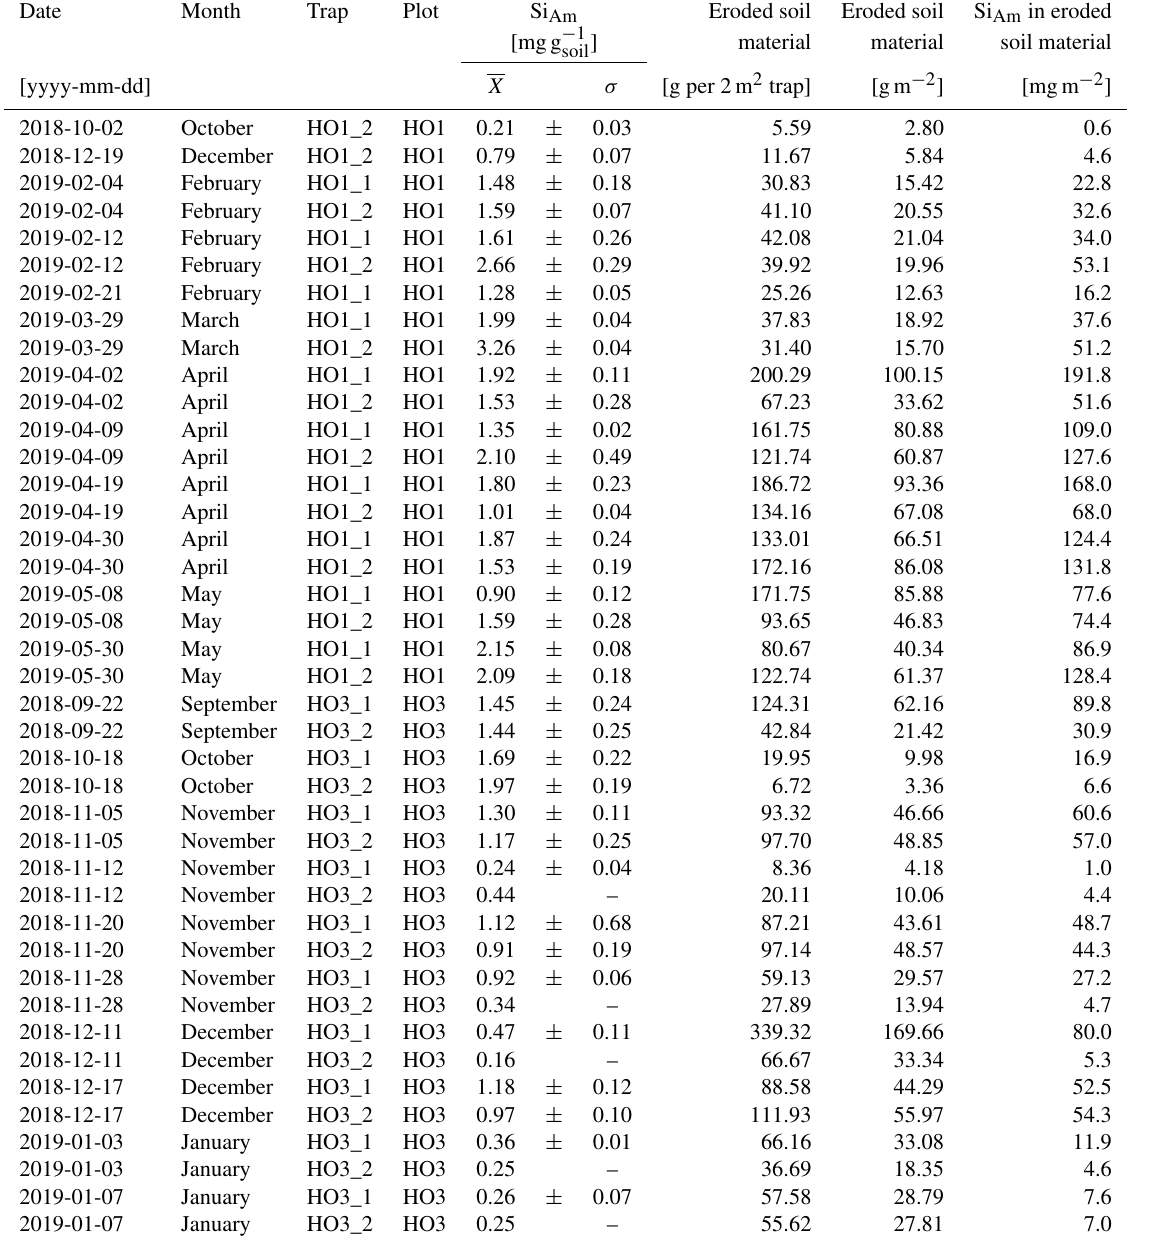
Table B3. Weekly loss of eroded soil material and Si Am in eroded soil material from sediment traps under oil-palm plantations (sloping